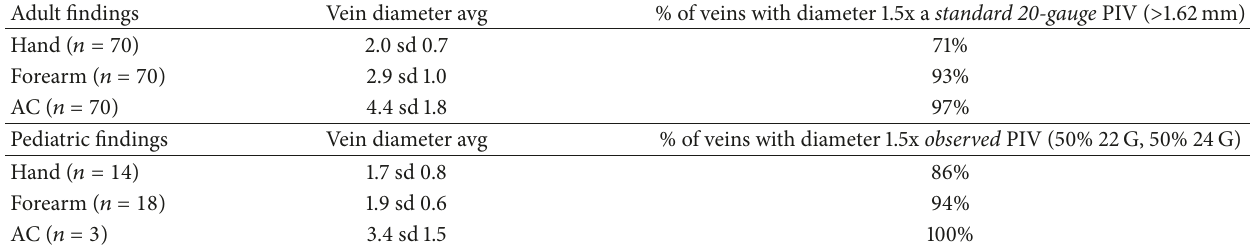
Table 1: Vein sizes by location in adult and pediatric patients.